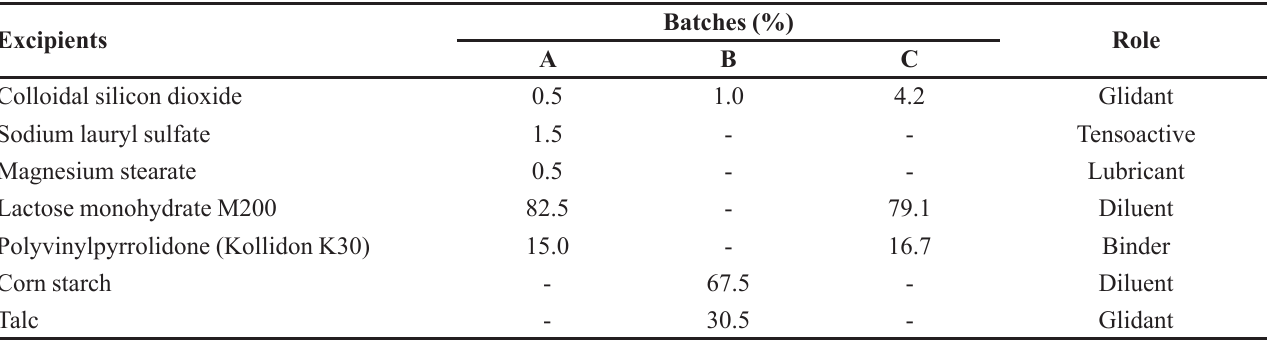
(Bedford, USA). TABLE I - Composition of batches A, B, and C